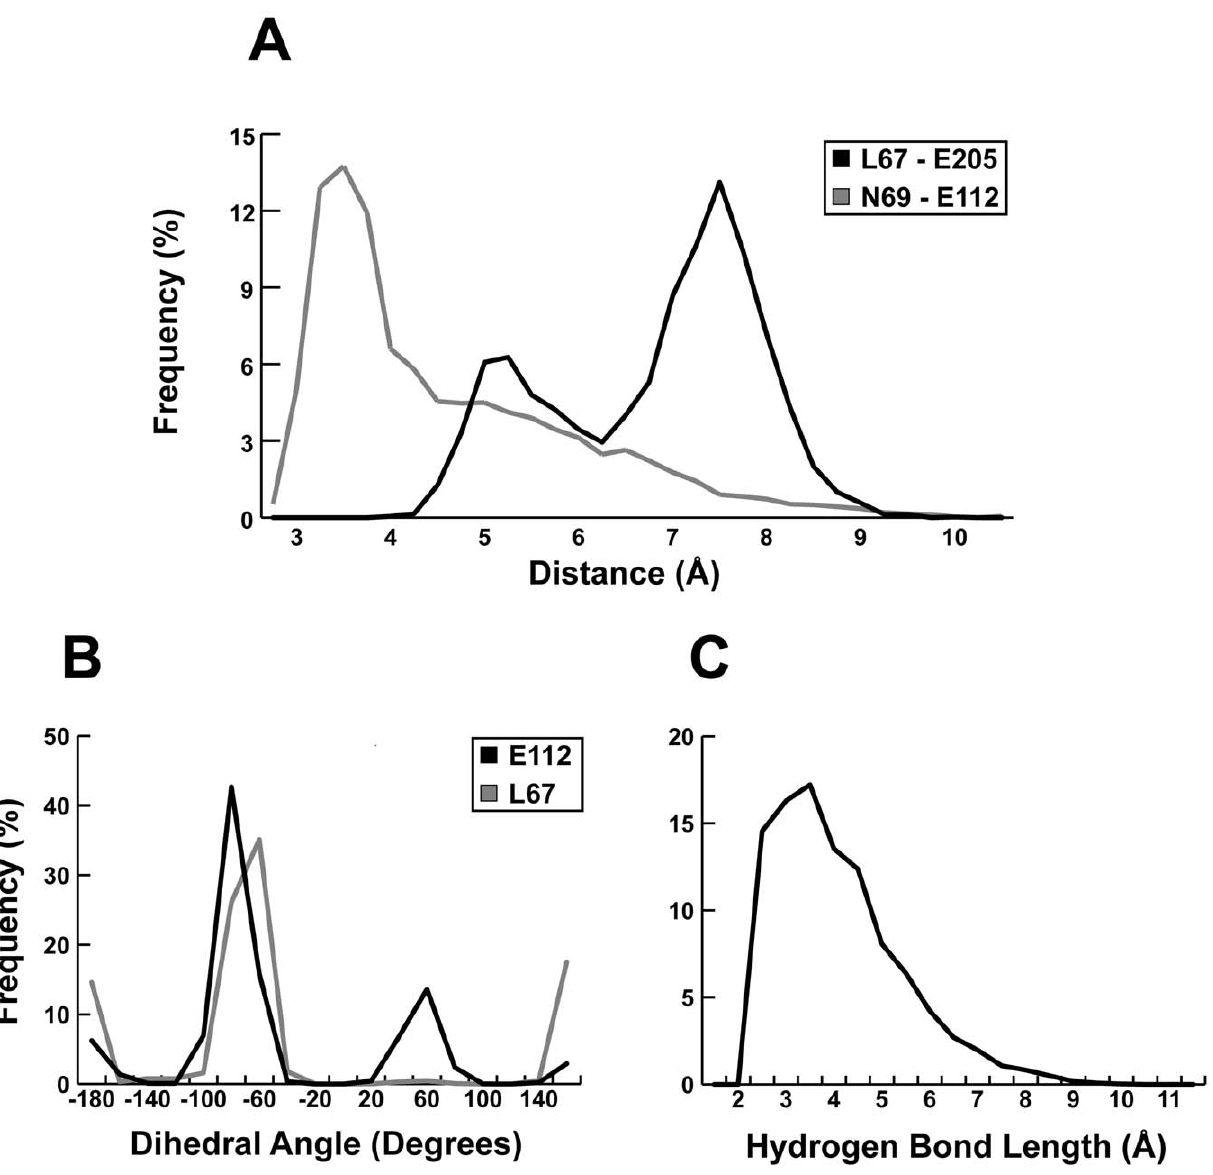
Figure 5. The opening and closing of the two ‘‘gates’’ that comprise the previously uncharacterized pocket. A) Histograms of the distances between the L67 c carbon atom and the E205 d carbon atom (the first gate, in black), and the distances between the N69 side-chain amino nitrogen atom and the E112 d carbon atom (the second gate, in gray), over all 100 ns of trajectory. When the L67-E205 distance is , 7.5 A˚, the first gate is open. When , 5.5 A˚, the gate is closed. Similarly, when the N69-E112 distance is , 6.0 A˚, the second gate is open; when , 3.5 A˚, the gate is closed. B) Histograms of the dihedral angles defined by the backbone amino nitrogen atom and the a , b , and c carbon atoms of L67 (in gray) and E112 (in black), respectively, measured over the course of the trajectory. The first gate is open when the L67 dihedral angle is , 60 u and closed when , 180 u . The second gate is open when the E112 dihedral angle is 60 u or 180 u , and closed when 2 60 u . C) A histogram of the distances between the N69 side-chain amino nitrogen atom and the E112 carboxylate oxygen atoms, demonstrating the formation of a transient hydrogen